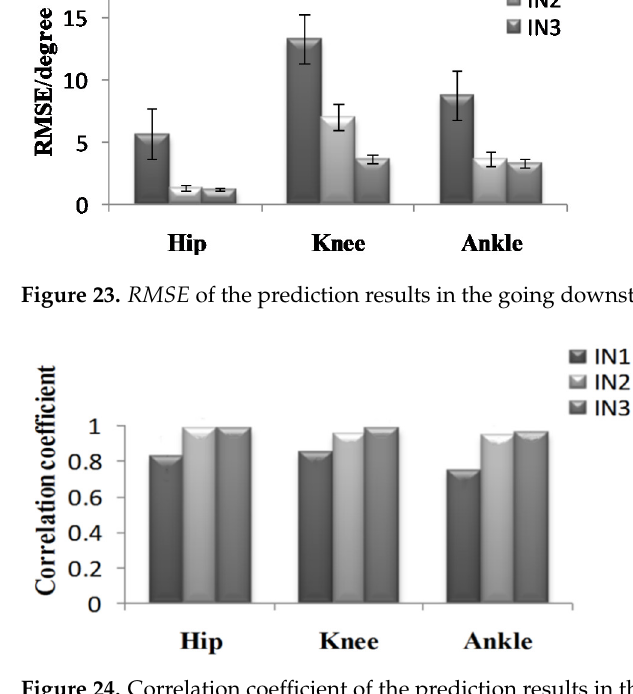
Figure 24. Correlation coefficient of the prediction results in the going downstairs process.